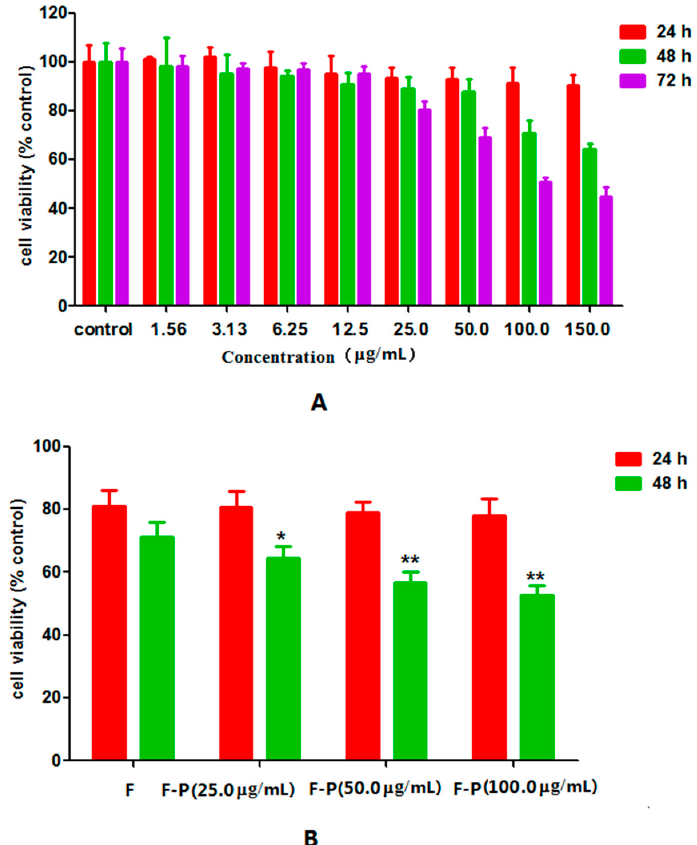
Figure 1. MTT results: ( A ) Cell viability of HepG2 cancer cells treated with different concentration of PHA for 24, 48 and 72 h; and ( B ) cell viability of combination treatment of 5-FU and PHA (* p < 0.05, ** p < 0.01, versus the 5-FU group). Table 1. The combination index (CI) values of combination treatment of 5-FU and PHA in HepG2 cells. PHA (µg/mL) Time (h)